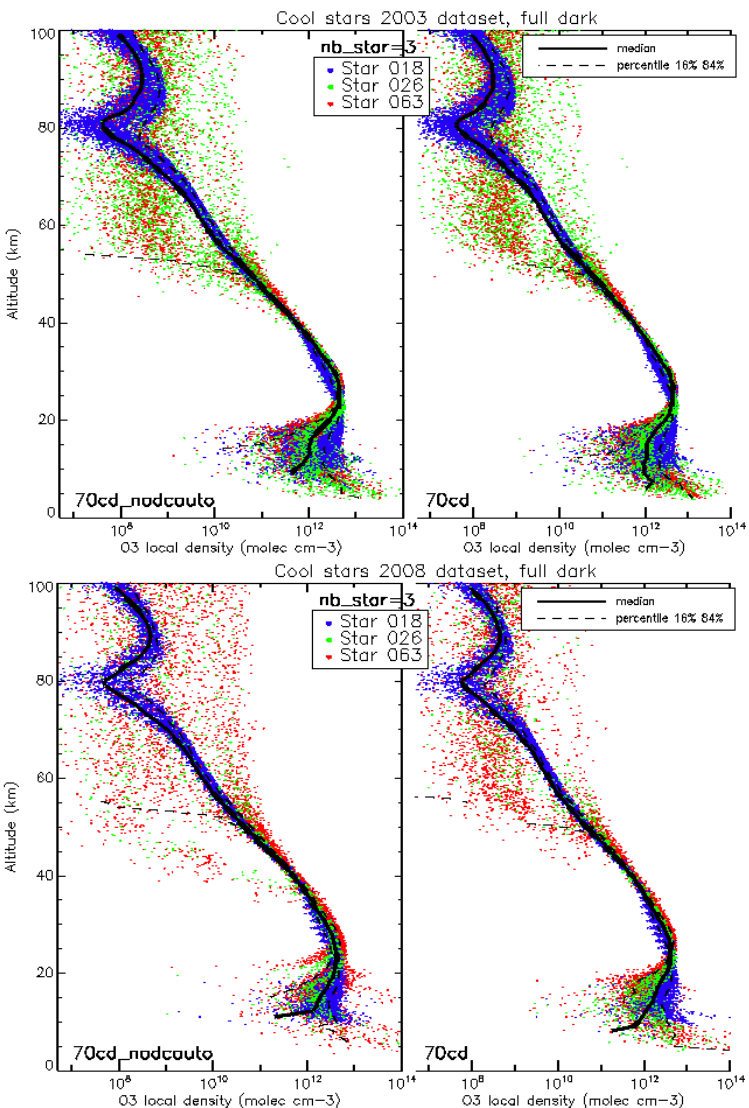
Fig. 5. O 3 line density profiles retrieved from occultations of 3 cool stars (smaller luminosity in the UV domain) in 2003 (Top) for dark background conditions processed with the GOPR v6.0cf algorithm including DSA dark charge estimate (left) and GOPR v7.0ab processing including background bands to better estimate the Dark Charge of the central band (right). Same analyses with the same stars are shown for the 2008 dataset